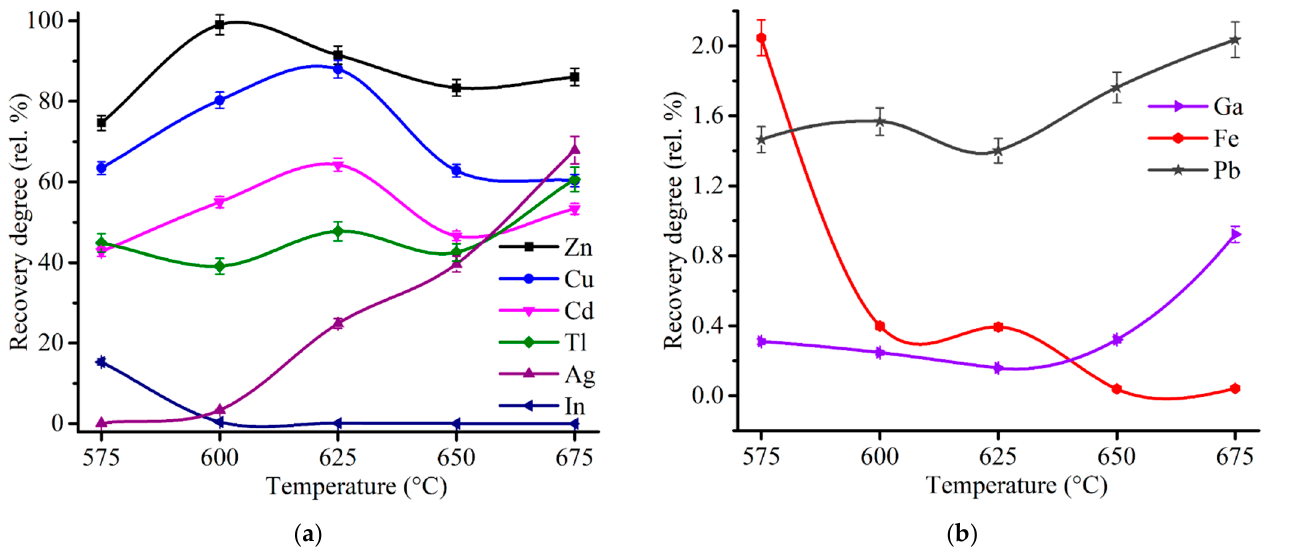
Figure 8. Effect of the roasting temperature on the recovery degree of Zn, Cu, Cd, In, Tl, Ag ( a ), as well as Ga, Fe and Pb ( b ) after 180 min of the roasting and subsequent water leaching with the addition of 48% Fe 2 (SO 4 ) 3 ∙ 9H 2 O to 100% ZPR.